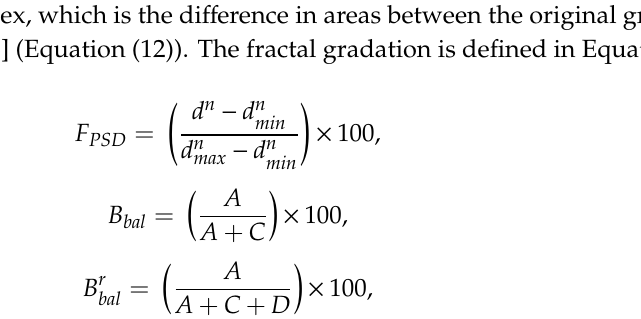
Figure 10. Criteria for calculation of 𝐵 (cid:3029)(cid:3028)(cid:3039) and 𝐵 (cid:3029)(cid:3028)(cid:3039) (cid:3045) [18].